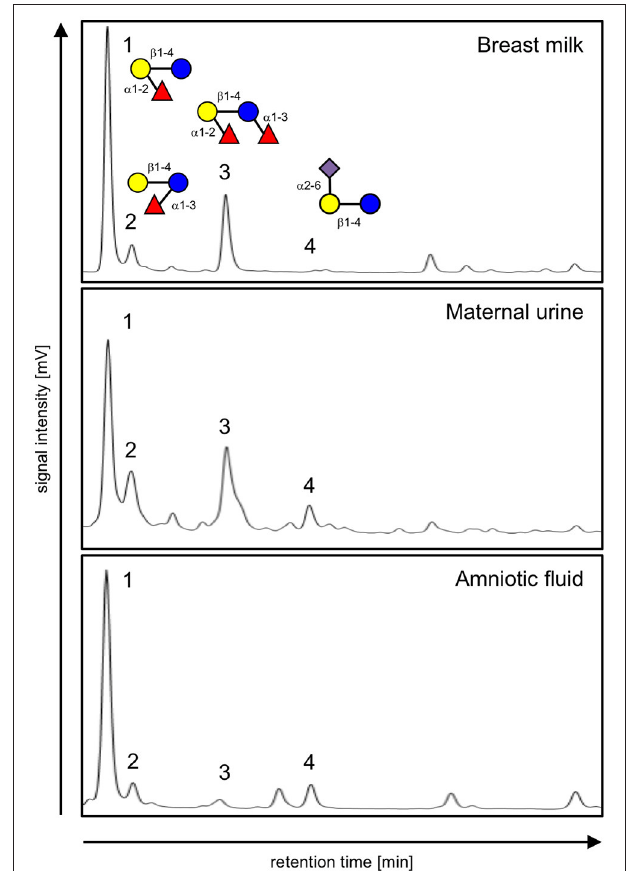
FIGURE 1 | HPLC chromatograms of 2AB-labeled oligosaccharides isolated from breast milk (top), urine (middle), and amniotic fluid (bottom) from the same subject. Peaks are identified as (1) 2 ′ -fucosyllactose, (2) 3-fucosyllactose, (3) difucosyllactose, and (4) 6 ′ -sialyllactose based on standard retention times as well as offline mass spectrometric analysis. Oligosaccharide composition is shown in the top panel with glucose (blue circle), galactose (yellow circle), fucose (red triangle) and sialic acid (purple diamond) as monosaccharide building